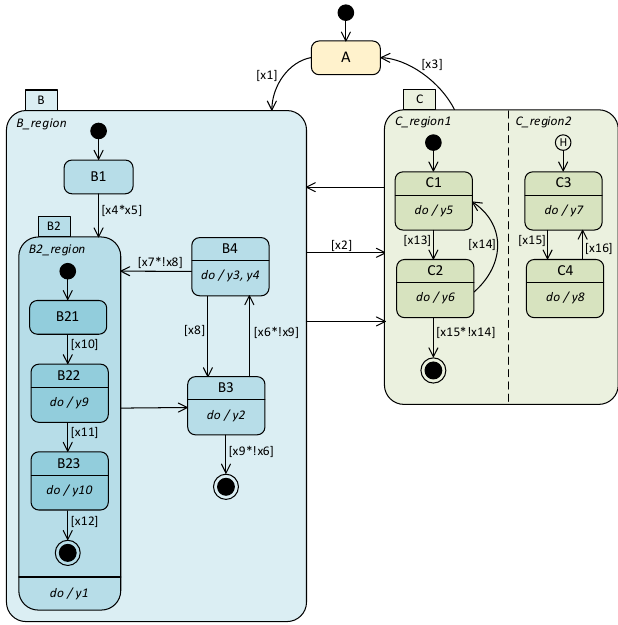
Figure 3. A detailed state machine diagram from Figure 2 (the lowest hierarchy level).